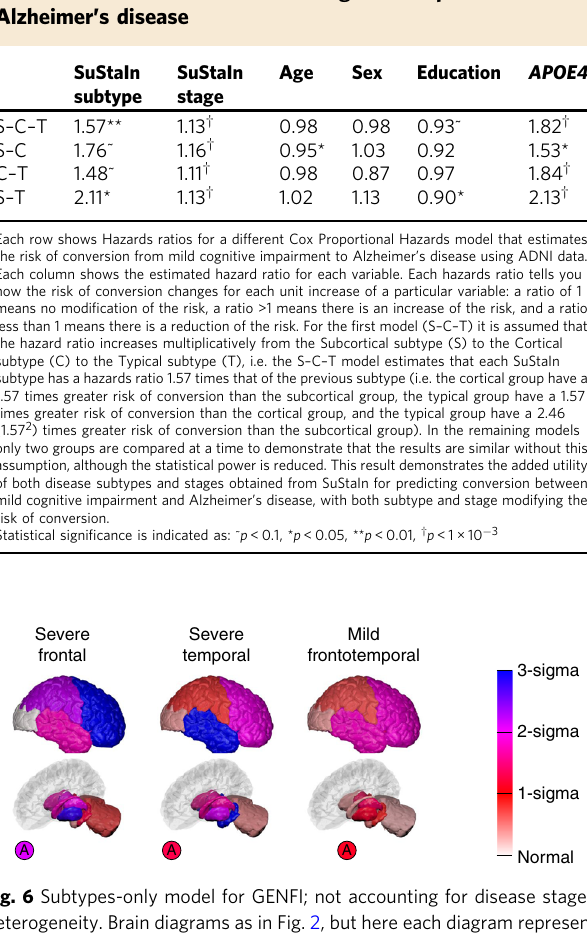
ogy and neuroanatomy.